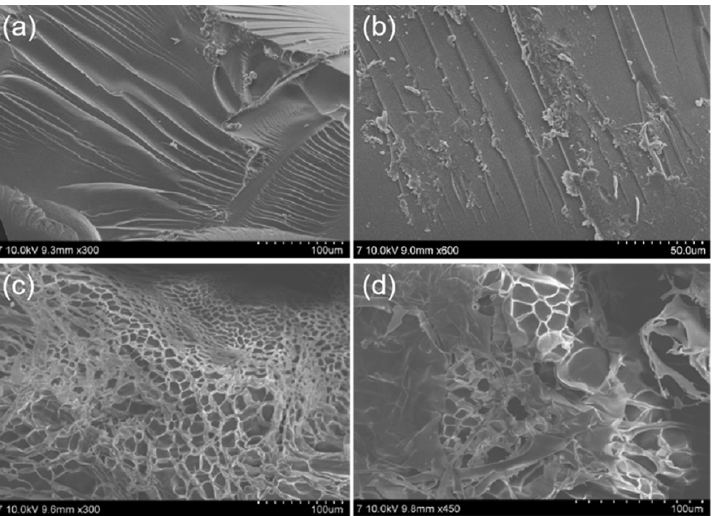
Figure 3. SEM images of ( a ) SAP0, ( b ) SAP1, ( c ) SAP2, and ( d )